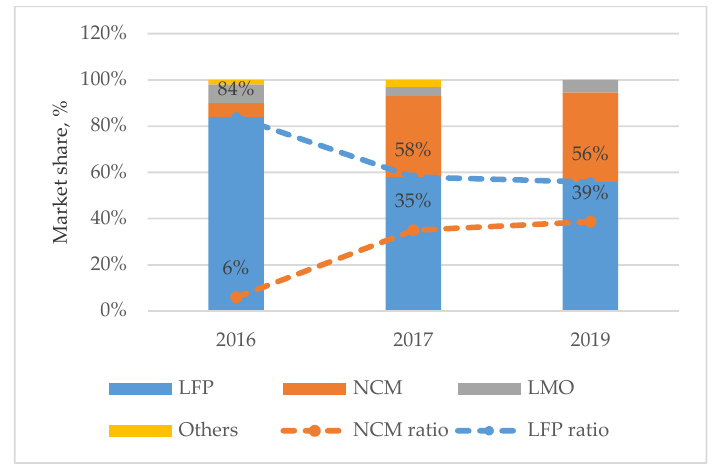
Figure 11. Market share of the various energy storage systems (ESSs) for BELVs.